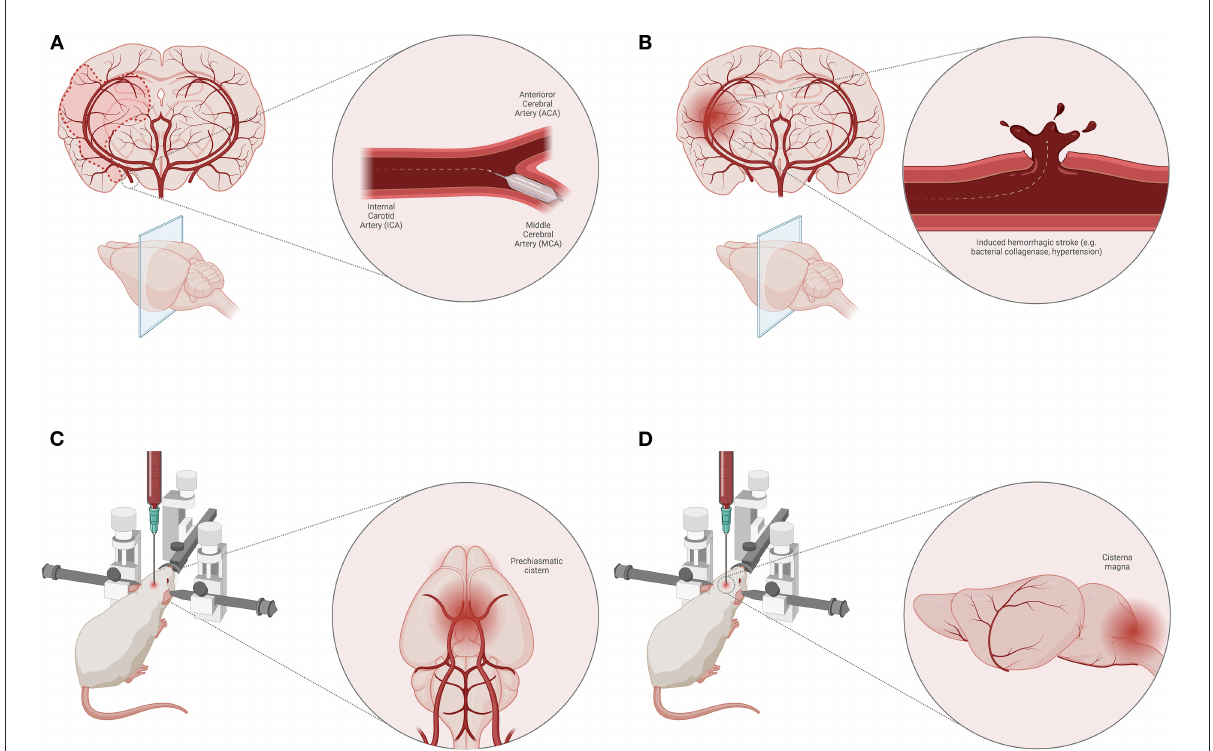
FIGURE2 Animal models of stroke. Middle cerebral artery (MCA) occlusion model of ischemic stroke (A) . Induced hemorrhagic stroke animal model (e.g., bacterial collagenase, induced hypertension) (B) . Blood injection techniques for SAH induction—pre-chiasmatic cistern (C) and cisterna magna (D)